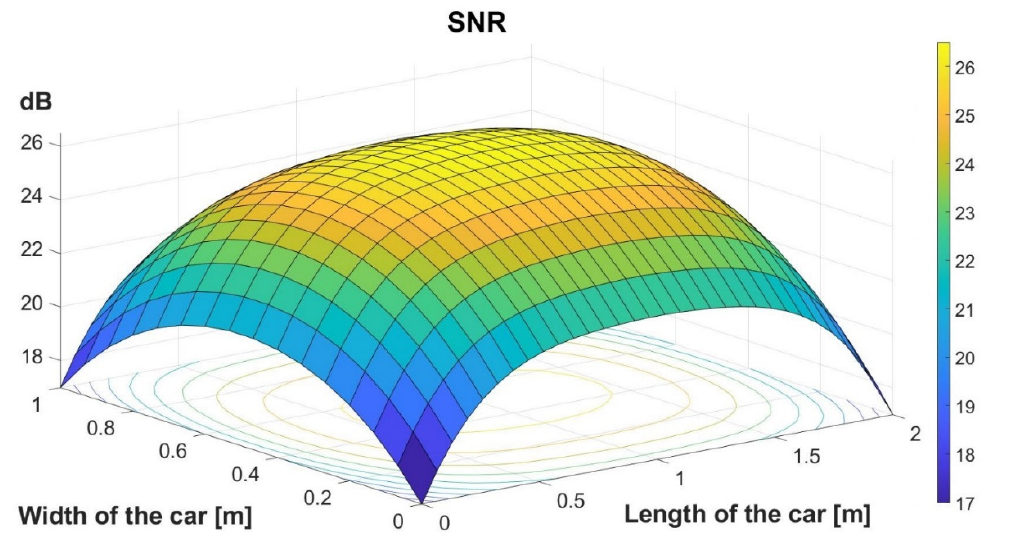
Figure 7. SNR distribution.